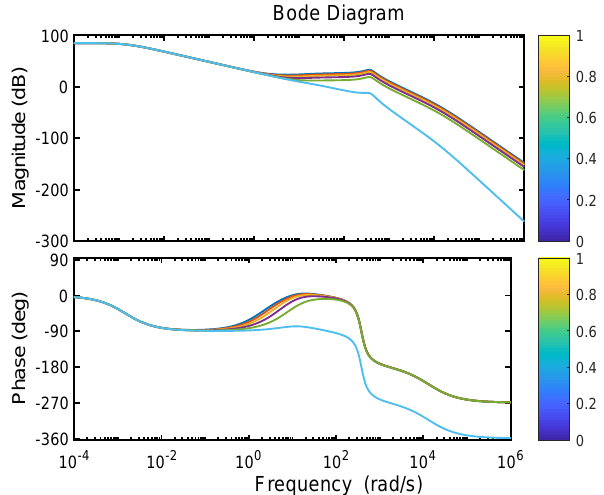
Figure 9. The bode diagram under the different k p .